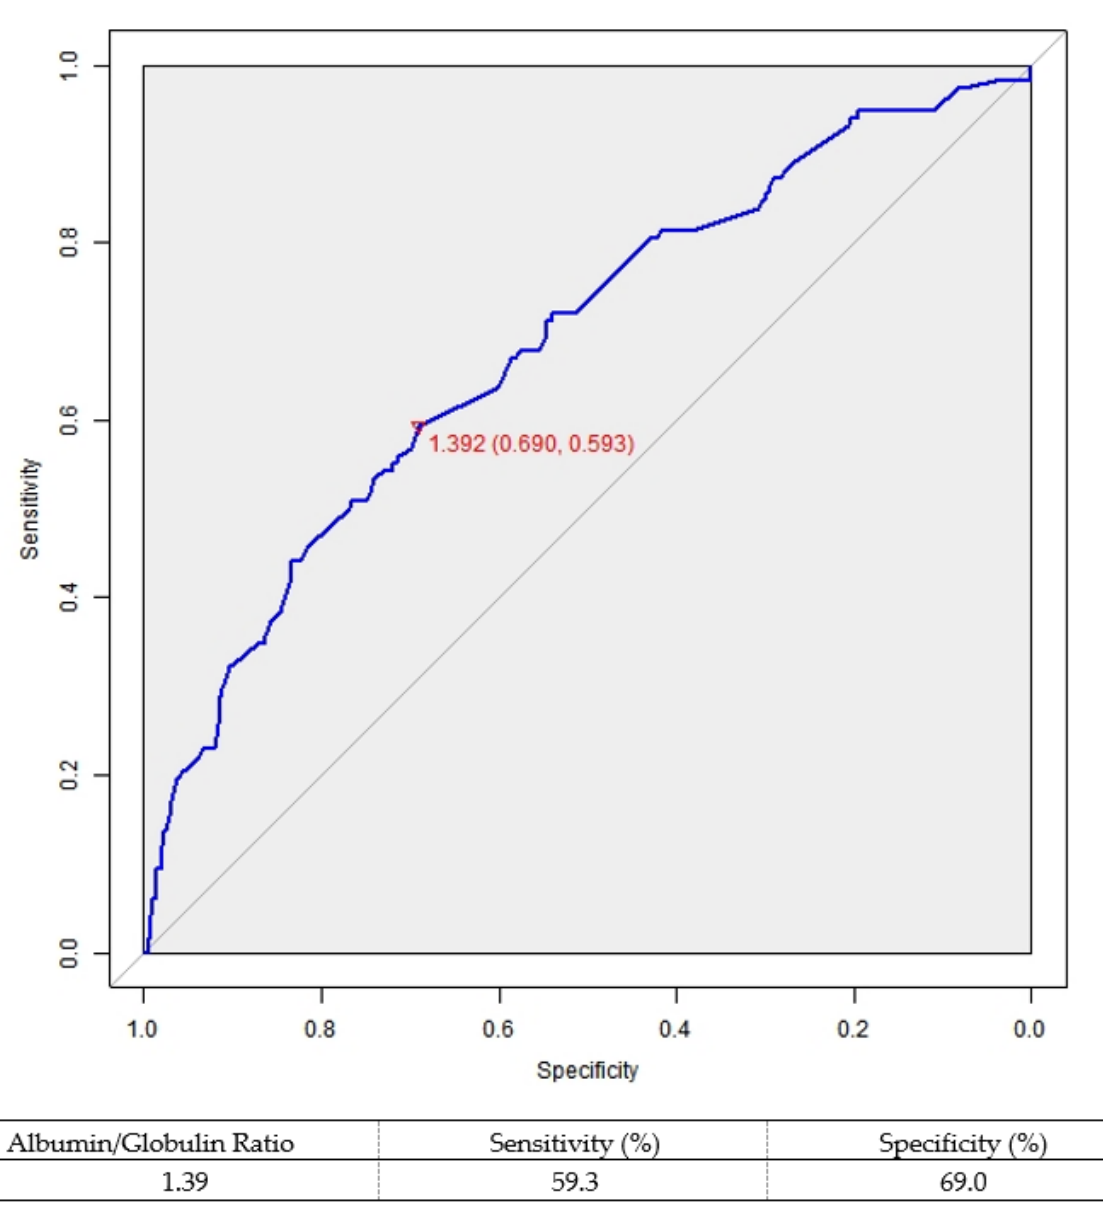
Figure 1. Receiver operator characteristic curve based on the albumin/globulin ratio.